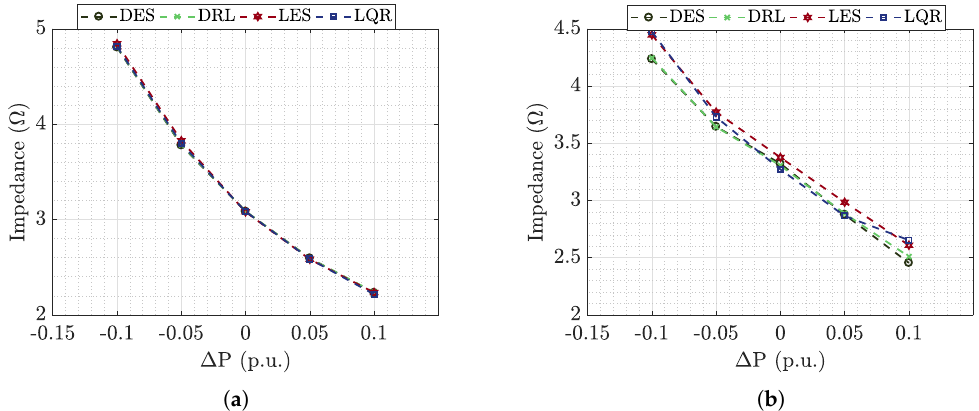
Figure 31. Mean CPL impedance for each power variation during the ( a ) simulation and ( b ) test.